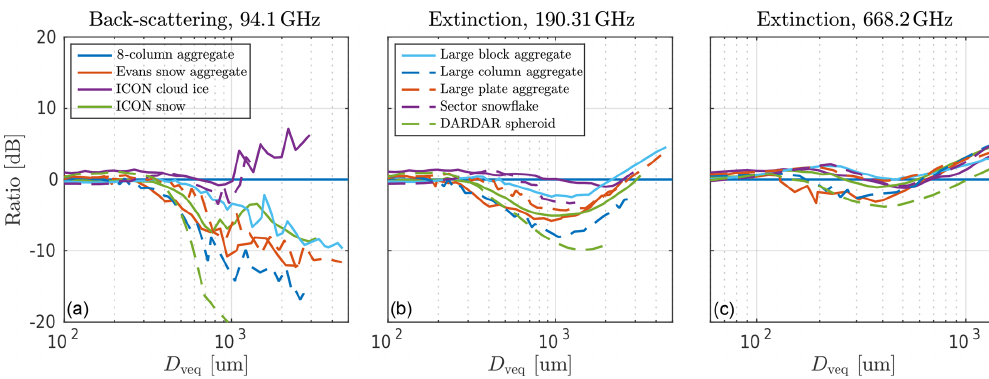
Figure 1. Backscattering ratio at 94.1GHz (a) and extinction ratio at 190.31GHz (b) and 668.2GHz (c) as a function of volume-equivalent diameter D veq . Legends are common to all panels. The ratios are calculated as the cross section of a given particle model divided by the cross section of the 8-column aggregate and are given in decibels. That is, − 3dB means that the backscattering or extinction cross section is half of the Hong aggregate cross section. All data assume totally random particle